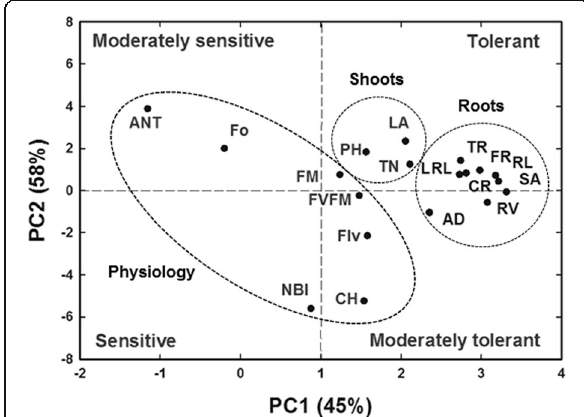
Fig. 7 Principal component analysis (PCA) for the first two principal components (PC) scores, PCA1 vs. PCA2 describing the classification salt response parameters measured 37 days after sowing for all the genotypes; plant height (PH), tillers number (TN), leaf area (LA), longest root length (LRL), total root length (TRL), root surface area (SA), average diameter (AD), root volume (RV), root tips (TP), forks (FR), crossings (CR), chlorophyll (CH), flavonoids (FLV), anthocyanin (ANT), and nitrogen balance index (NBI)